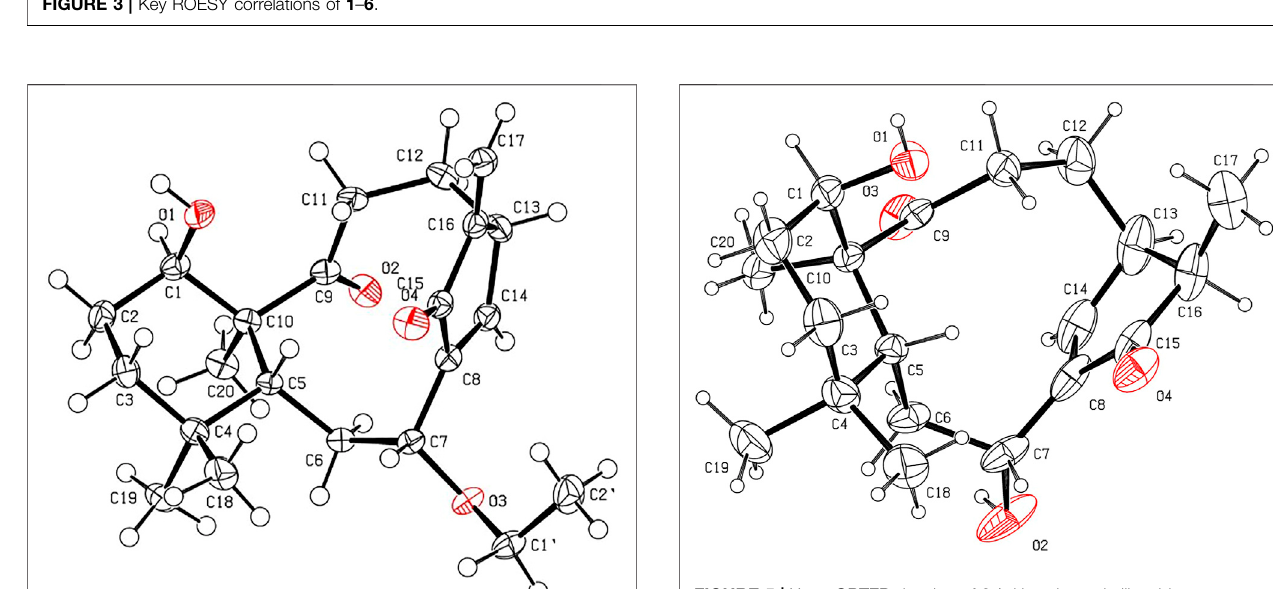
FIGURE 3 | Key ROESY correlations of 1 – 6 .